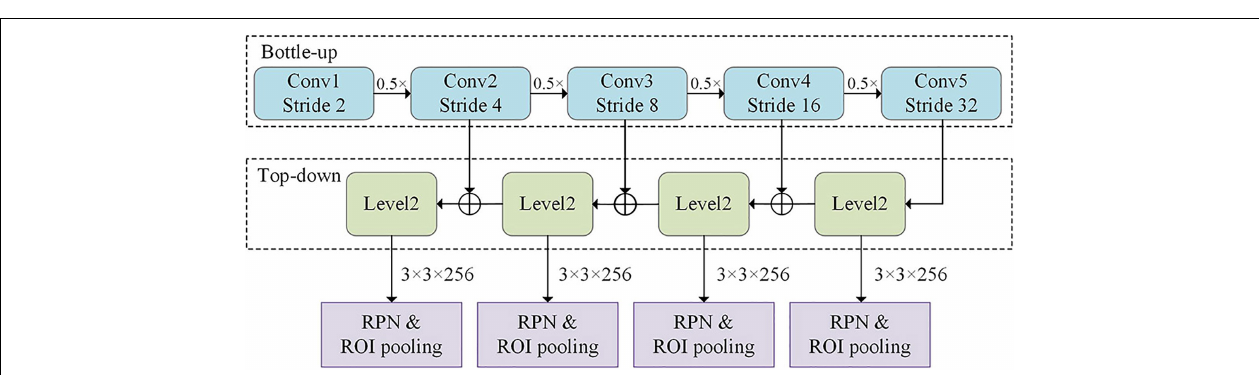
Frontiers in Marine Science |